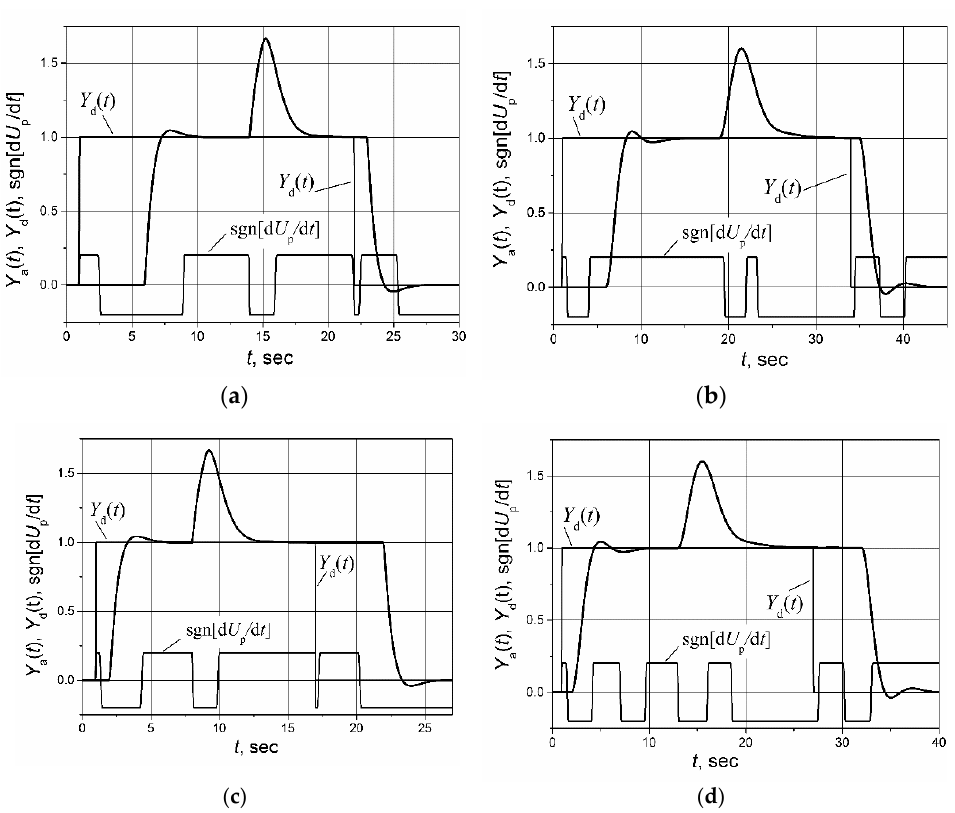
Figure 7. The set-point unit pulse and unit-load disturbance-response of the control system of the first-order ( a ) and second-order ( b ) plants with asymmetric response delay ( T r = 5 s, T f = 1 s) and the first-order ( c ) and second-order ( d ) plants with asymmetric response delay ( T r = 1 s, T f = 5 s) based on the PI controller with the switched-delay Smith predictor. Load disturbance occurs at the time moments t = 9 s ( a ), t = 14 s ( b ), t = 7 s ( c ) and t = 12 s ( d ). The sgn[d U p /d t ] is the sign of the plant-control signal time derivative.